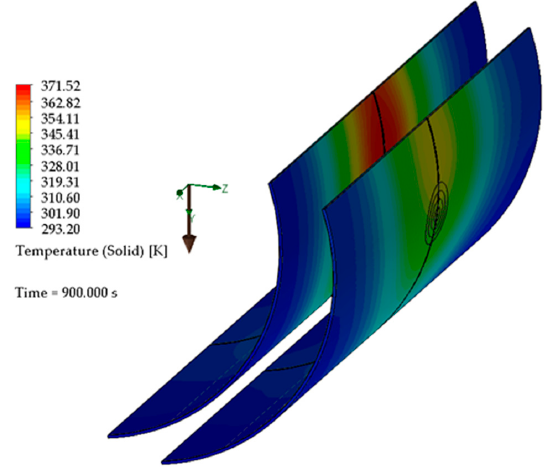
Figure 22. Temperature at 900 s.